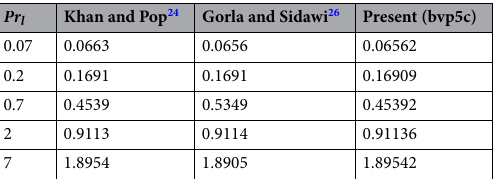
Table 1. Comparison of –θ’(0) values with those of Khan and Pop 24 and Gorla and Sidawi 26 when Nb = Nt = (cid:31) = β E = φ = 0 and Bi = 10, 000 .